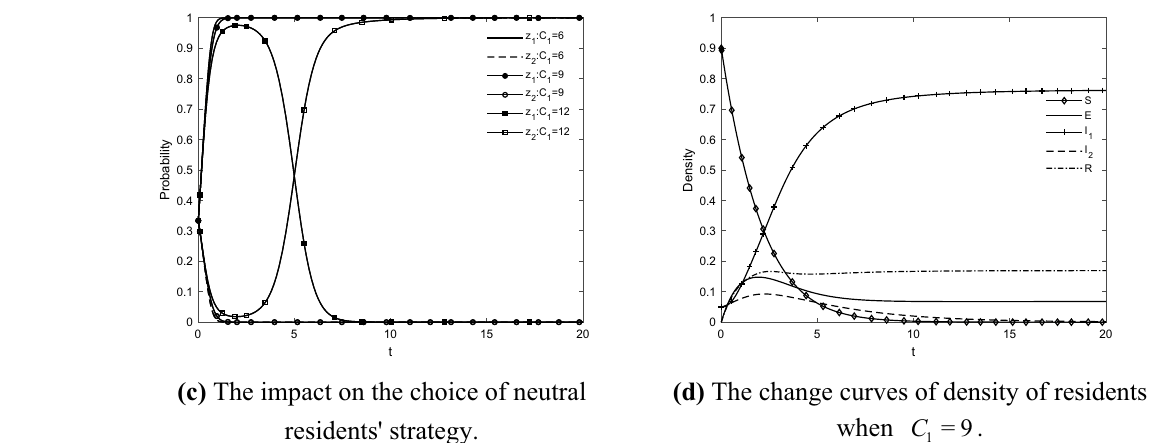
(a) The impact on the choice of the government's strategy.